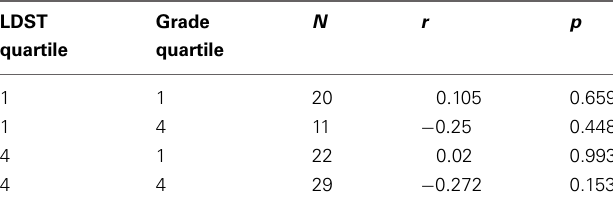
Table 2 | Correlations between school grades and LDST performance. LDST